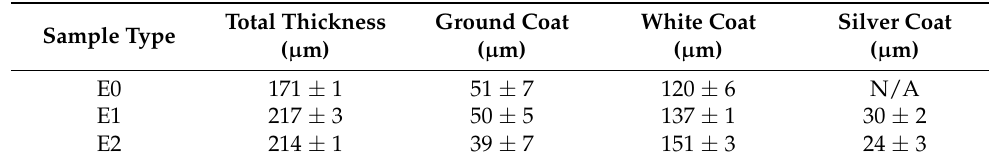
Table 2. Sample thickness measurements.